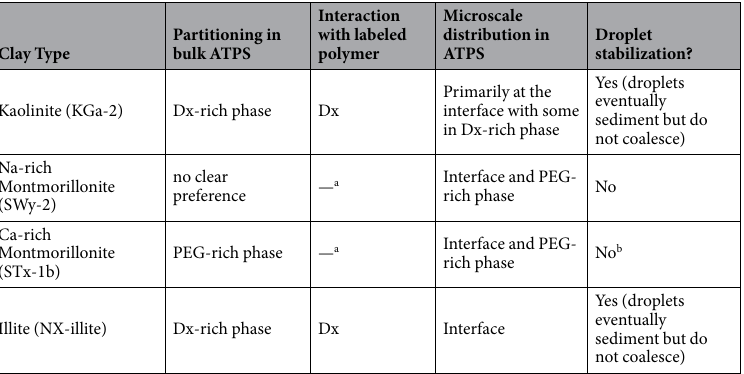
Table 2. Summary of clay mineral behavior in 15%/15% w/w PEG/Dx ATPS. a No apparent adsorption of either labeled polymer to majority of particles in these samples. Non-montmorillonite impurity particles in these samples interact with labeled dextran; see text and Supporting Information for discussion. b Ca montmorillonite particles in PEG-rich phase sometimes physically block contact of Dx-rich droplets; they do not accumulate at or stabilize the